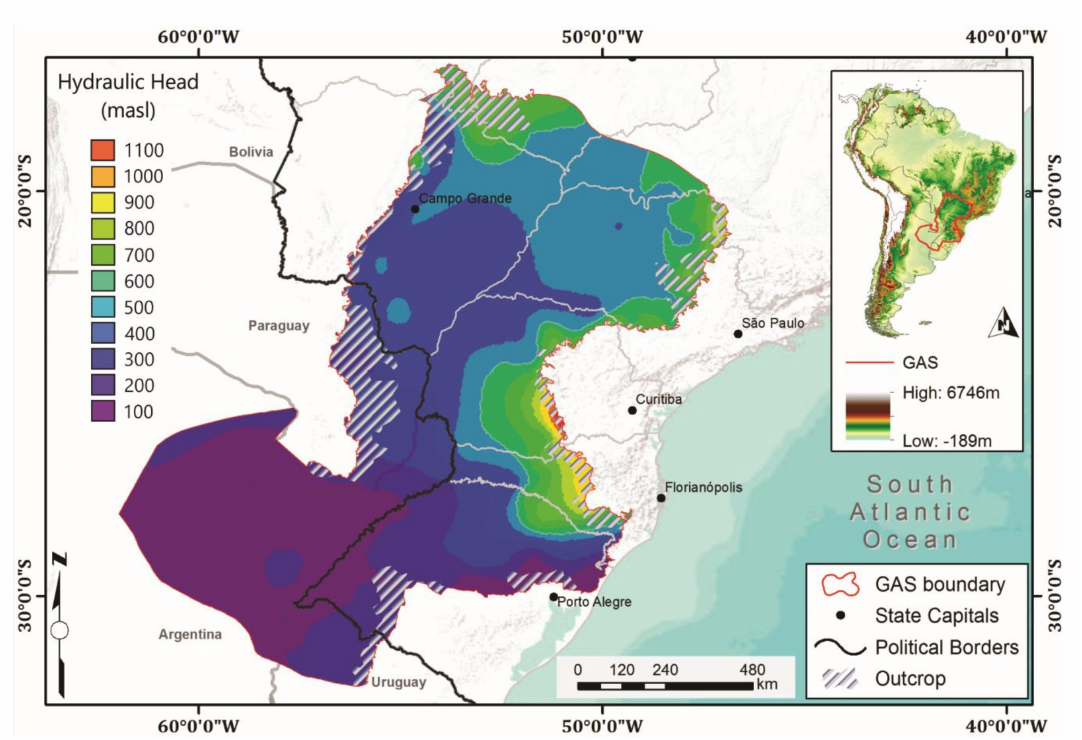
Figure 2. Location of the study area and observed potentiometric levels (modified from [9]) of the Guarani Aquifer